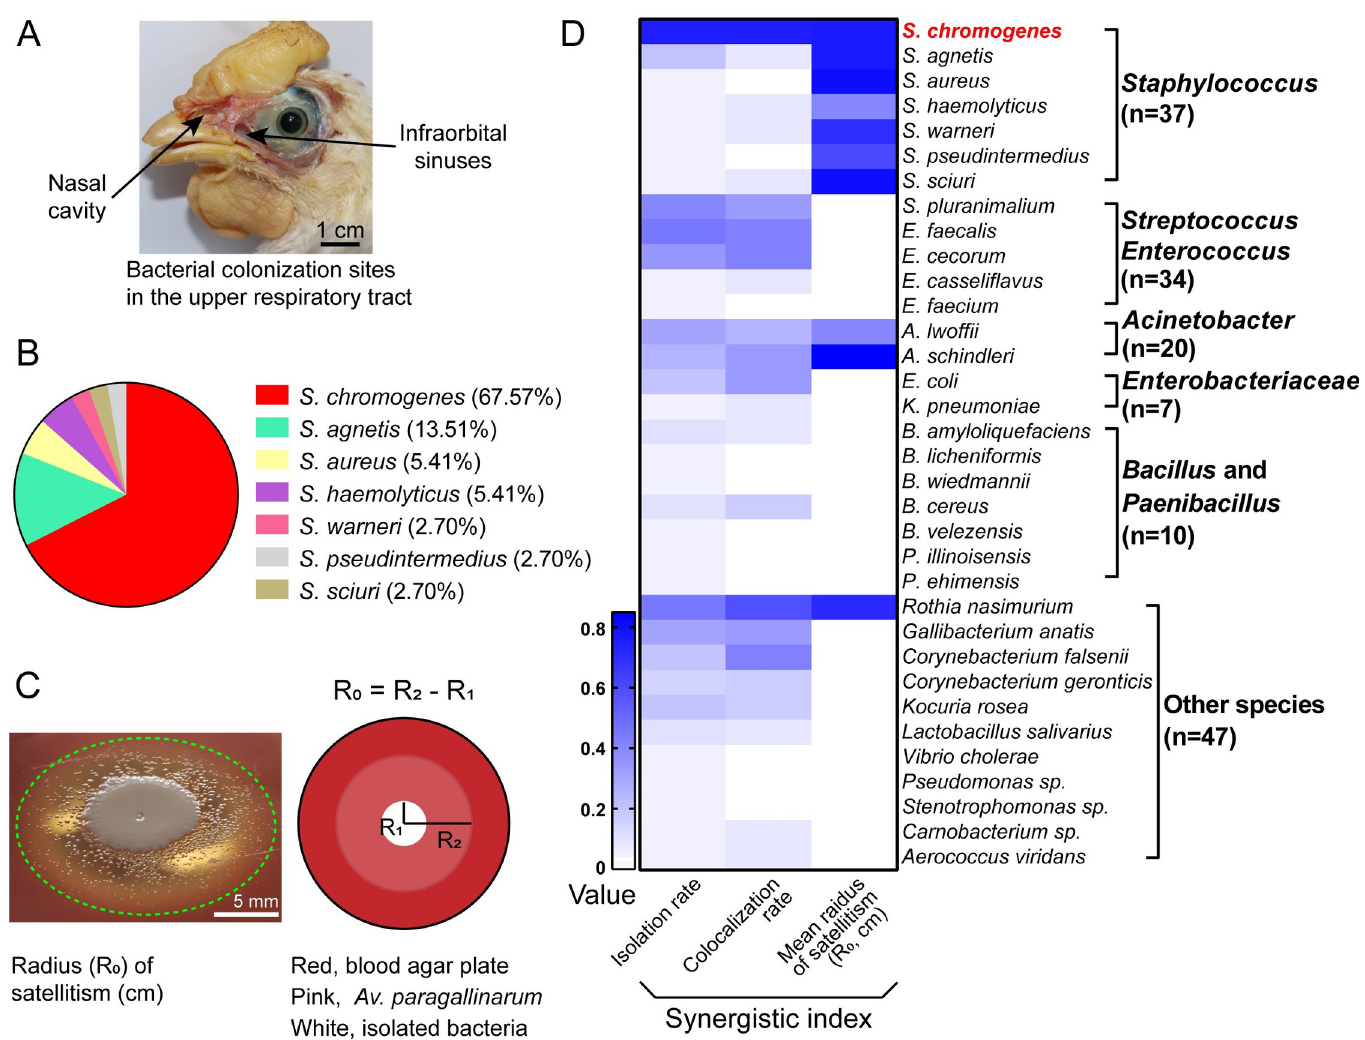
Fig 1. S . chromogenes is closely related to Av . paragallinarum infection. (A) Bacterial samples were collected from the nasal cavity and infraorbital sinuses of 20 birds with clinical symptoms. (B) Distribution of Staphylococcus spp. (C) Representative image of the satellitism of Av . paragallinarum on blood agar plates after cocultivation for 48 h. (D) Custom synergistic indexes, including the isolation rates (0–1), colocalization rates (0–1), and the mean radii of satellitism